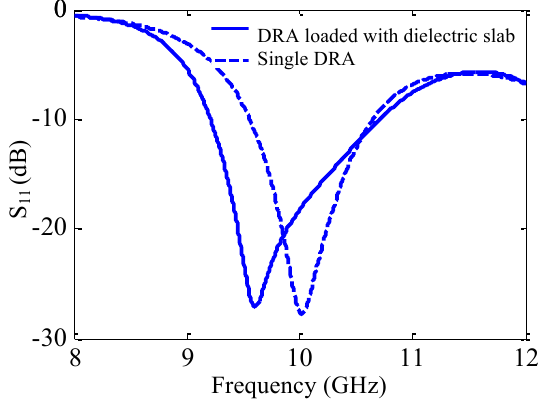
Figure 3: Reflection coefficient versus frequency for DRA loaded with dielectric slab compared to a single DRA.